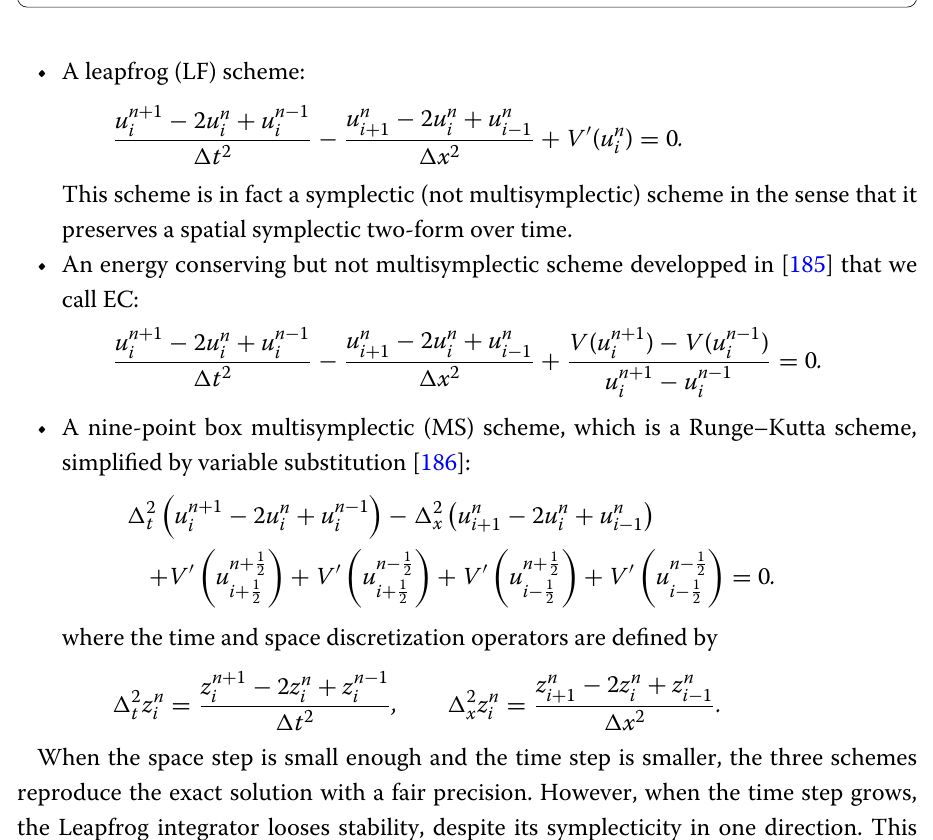
Fig. 11 Approximate solutions for t ∈ [0;30], with (cid:7) t = 5 . 10 − 2 , (cid:7) x = 5 . 10 − 2 . a Leapfrog scheme. b Multisymplectic